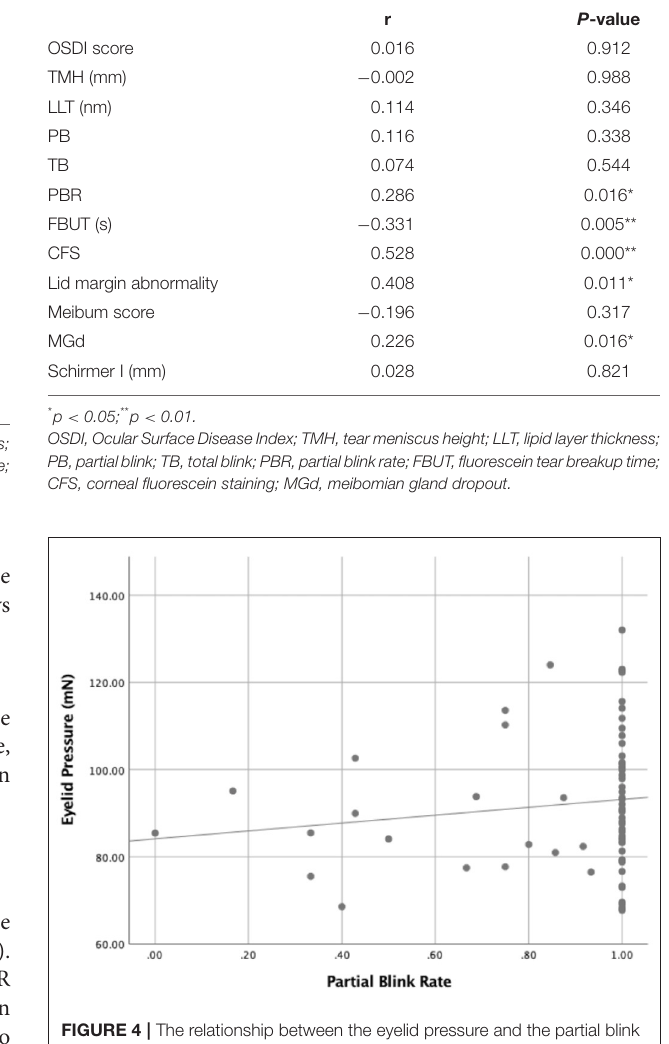
FIGURE 4 | The relationship between the eyelid pressure and the partial blink rate (PBR) (r = 0.286, P =